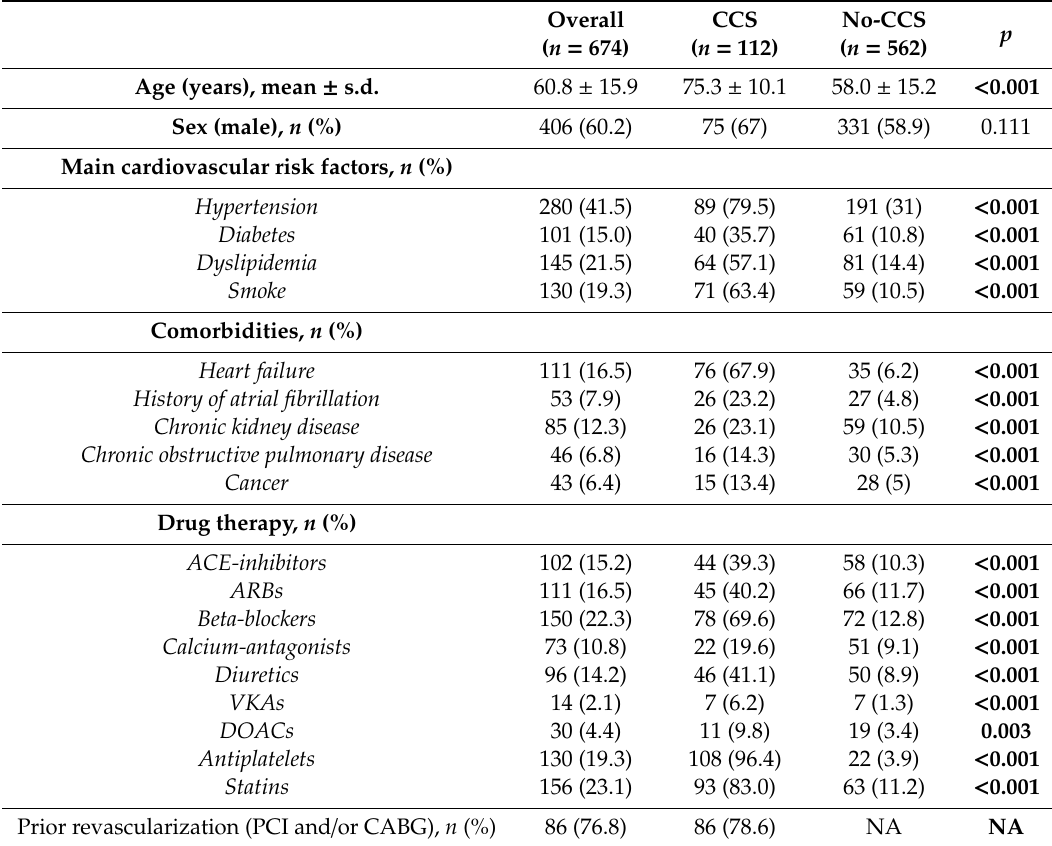
Table 1. Baseline characteristics of the study cohort.